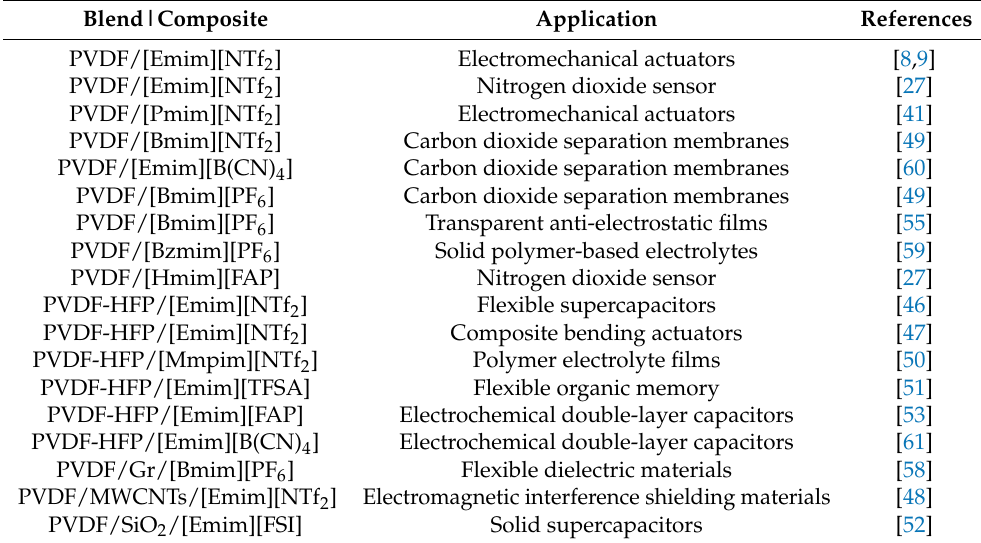
Table 10. Applications of PVDF/and PVDF-HFP/hydrophobic imidazolium-based ionic liquid blends and